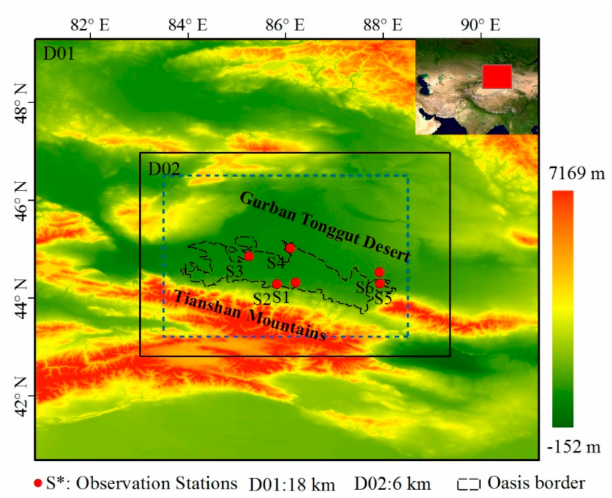
Figure 1. Location of the northern Tianshan Mountains (NTM) in Central Asia, including land surface elevations, meteorological sites, and simulation domain over the NTM (the blue dashed line is the analysis range).